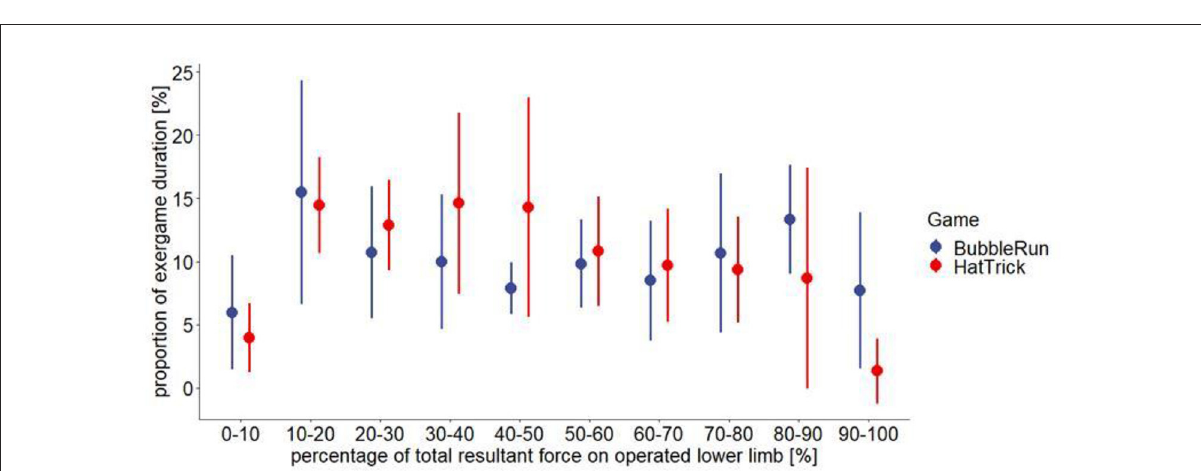
FIGURE2 The resultant force (the mean and SD) produced by the operated lower limb ( n = 7) during weight shifting exergames (the Bubble Runner and Hat Trick).